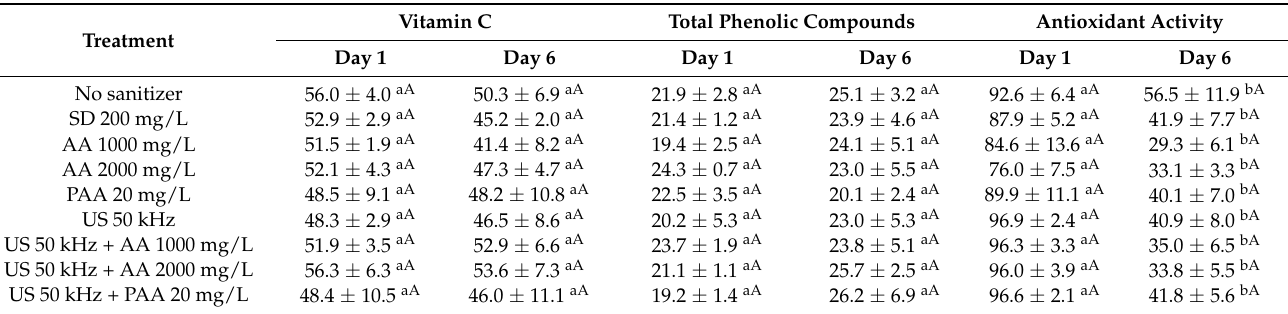
Table 3. Average and standard deviation of vitamin C (mg of ascorbic acid/100 g), phenolic com- pounds (mg gallic acid equivalent/100 g), and antioxidant activity (%) in kale samples after sanitiza- tion and storage at 7 ◦